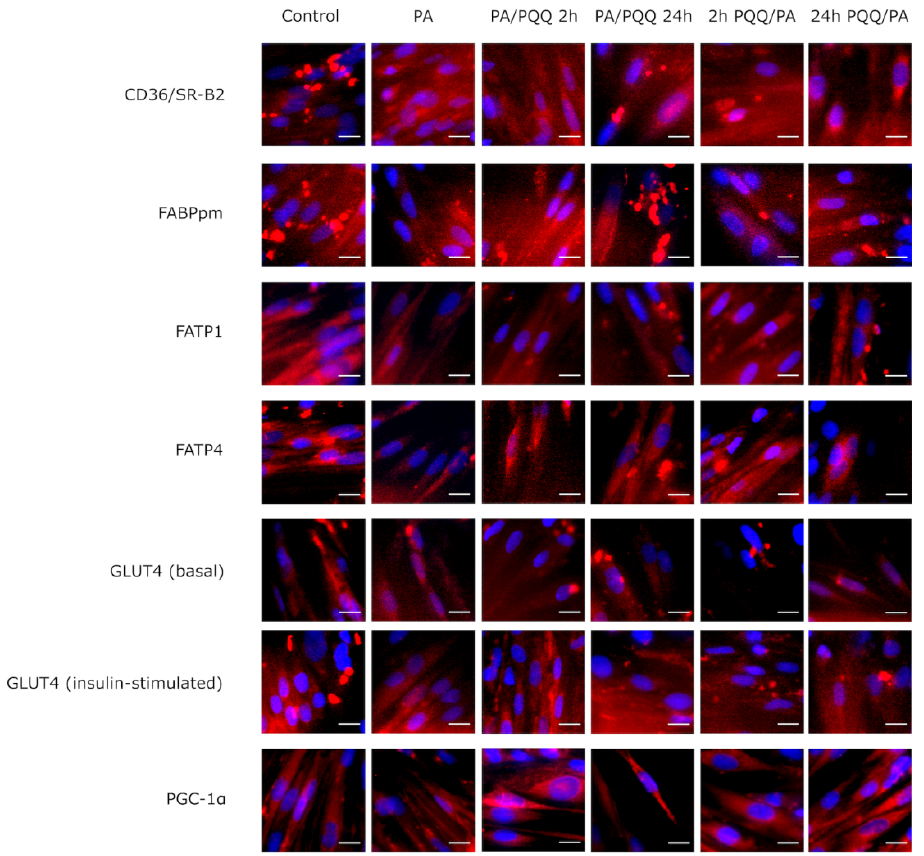
Figure 4. Effects of short- and long-time incubation with PQQ on the intracellular localization of fatty acid translocase/CD36 (CD36/SR-B2), plasma membrane-associated fatty acid binding protein (FABPpm), fatty acid transport protein 1 (FATP1), fatty acid transport protein 4 (FATP4), glucose transporter 4 (GLUT4) and peroxisome proliferator-activated γ co-activator 1 α (PGC-1 α ). The fluorescence intensities of stained cells were analyzed using a BD Pathway 855 confocal microscope with a 40× (0.75 NA) objective. Scale bars (bottom right) are 15 µm. PA: palmitic acid; PQQ: pyrroloquinoline quinone.